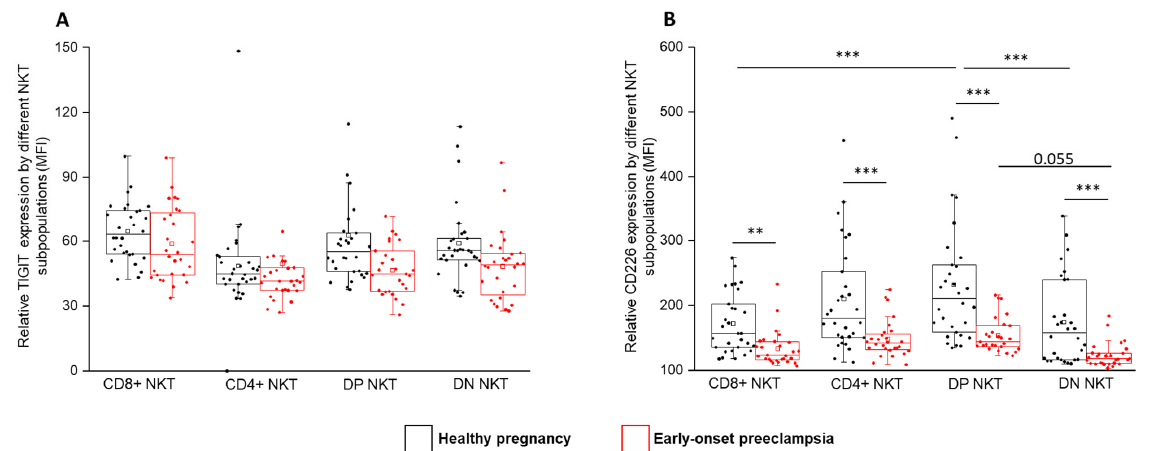
Figure 7. Relative TIGIT and CD226 expression by different NKT cell subpopulations in EOP and healthy pregnancy. Mean fluorescent intensity of the TIGIT ( A ) and the CD226 ( B ) receptors by the CD8 and CD4 surface molecule positive and negative NKT cell subpopulations in EOP patients and healthy pregnant women. The solid bars represent medians of 39, 40, 39 and 28 determinations, respectively. The boxes indicate the interquartile ranges, and the whiskers show the most extreme observations. The middle square within the box represents the mean value. Significant differences with p ‐ values < 0.01 *** and <0.03 ** are indicated.